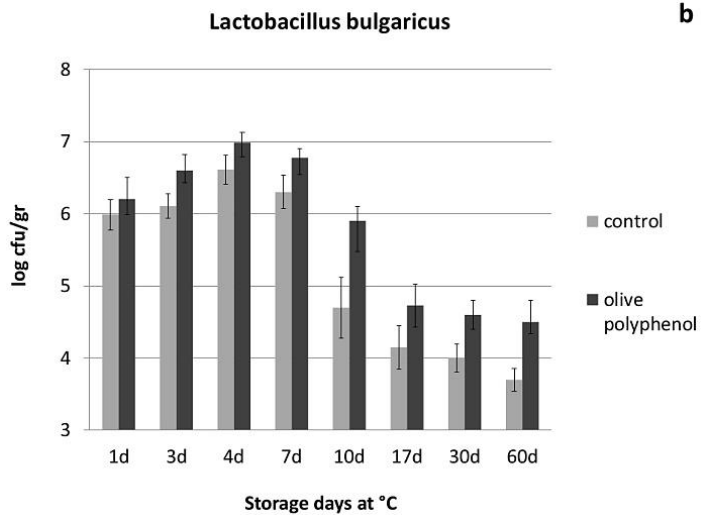
Figure 3. Population of Lactobacillus bulgaricus during fermentation ( a ) and refrigerated storage ( b ) of yogurts with or without addition of 1250 ppm of olive polyphenols.